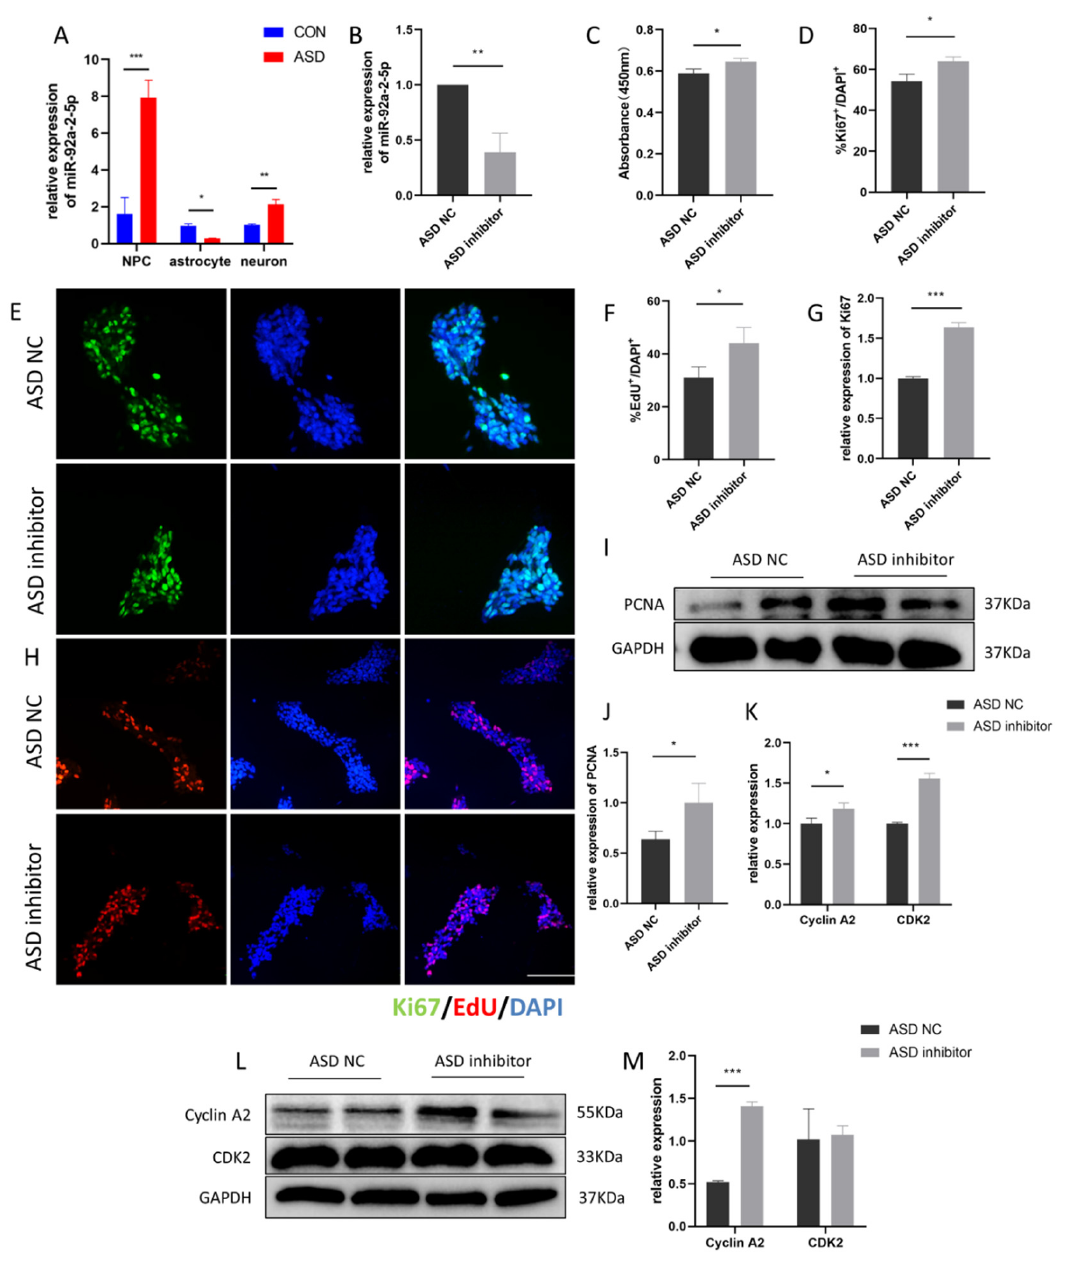
Figure 4. miR-92a-2-5p modulates the proliferation of ASD-NPCs. ( A ) Relative expression of miR- 92a-2-5p in ASD-NPCs, astrocytes, and neurons, as determined by RT-qPCR. ( B ) Verification of decreased expression of miR-92a-2-5p 24 h after transfection with miR-92a-2-5p inhibitor in ASD- NPCs using RT-qPCR. ( C ) Cell viability was assessed via CCK-8 assays in ASD NC and ASD inhibitor. ( D , E ) ASD NCs and ASD inhibitor NPCs were immunostained with anti-Ki67 (green). DAPI (blue) was used to stain nuclei. The percentage of Ki67-labeled cells was calculated after transfection with miR-92a-2-5p inhibitor. ( F ) Relative mRNA expression of Ki67 in ASD NC and ASD-inhibitor NPCs determined by RT-qPCR. ( G , H ) ASD NC and ASD inhibitor NPCs were stained with DAPI (blue) and EdU (red). The percentage of EdU-labeled cells after transfection with miR-92a-2-5p inhibitor was calculated. ( I,J ) Relative expression of PCNA in ASD NC and ASD inhibitor NPCs determined by western blot. ( K – M ) Relative expression of Cyclin A2 and CDK2 of ASD NC and ASD inhibitor NPCs, as determined by RT-qPCR and western blot. All data represent mean ± SEM; scale bar: 100 µ m; *** p < 0.001, ** p < 0.01, * p <